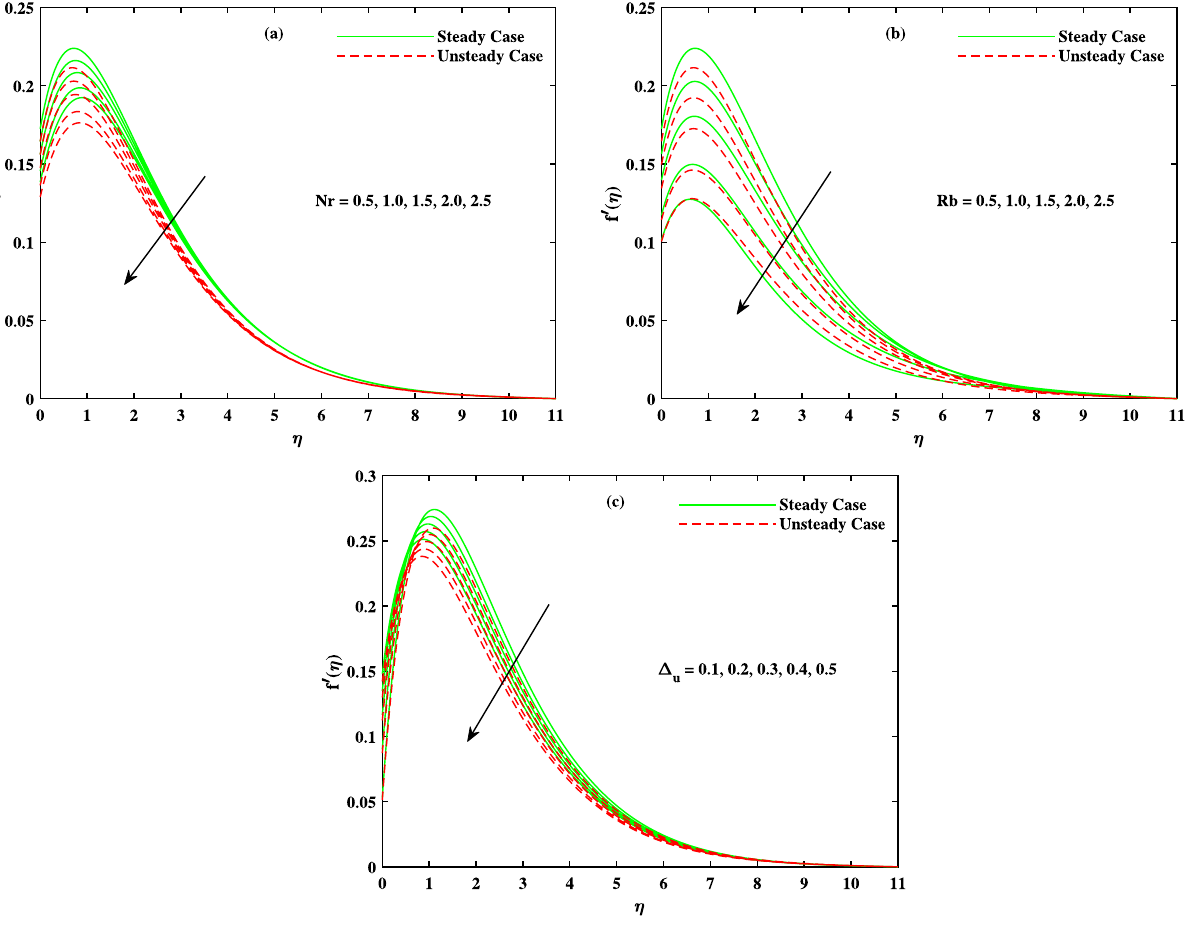
Figure 3. Fluctuation in x-direction velocity f ′ (η) with ( a ) Nr , ( b ) Rb and ( c ) (cid:31) u